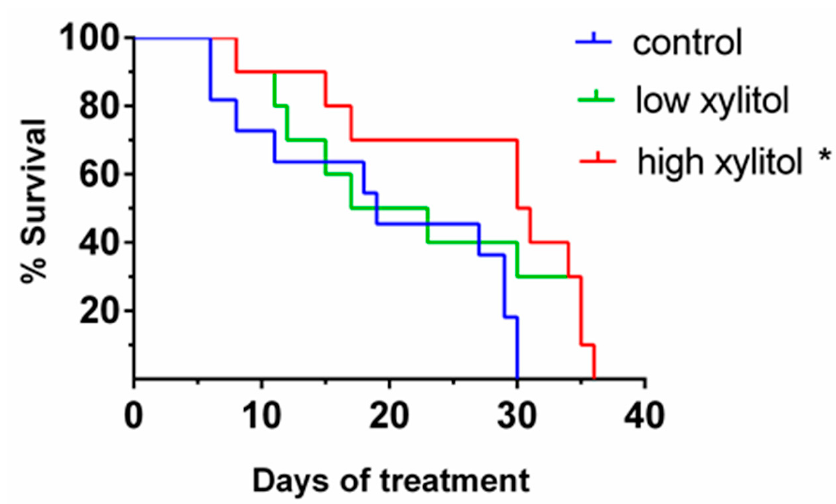
Figure 6. Percent survival of CAL-27 xenograft mice given the glucose solution (control), low-xylitol solution (experimental group 1), and high-xylitol solution (experimental group 2). Changes over time for each group were depicted as Kaplan–Meier curves. * represents p < 0.05, obtained from the log-rank test. p = 0.0105 comparing between high-xylitol and control groups, p = 0.2337 comparing between low-xylitol and control groups.